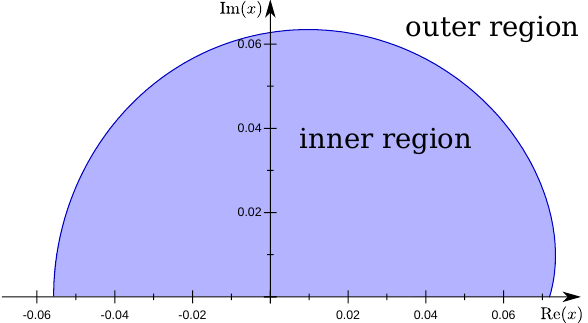
√ √ 5 and x = 7 − 4 3 . In order to construct a